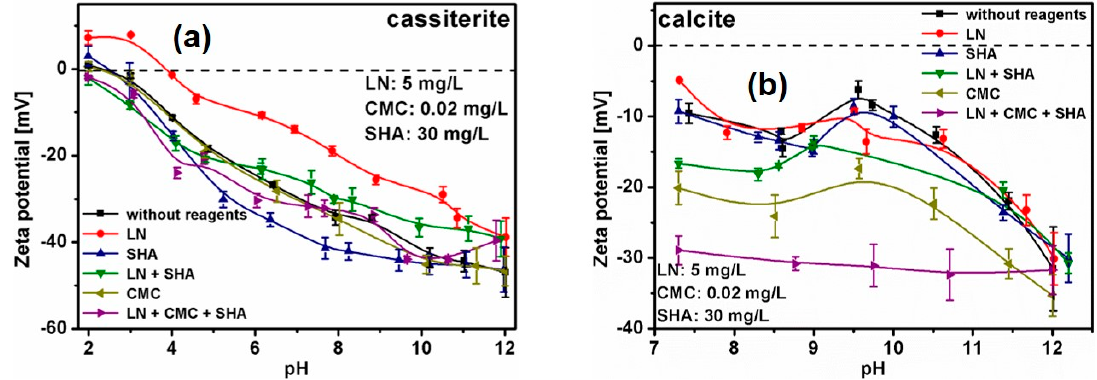
Figure 6. Zeta potential values of cassiterite ( a ) and calcite ( b ) as a function of pH in the absence and presence of different reagents.